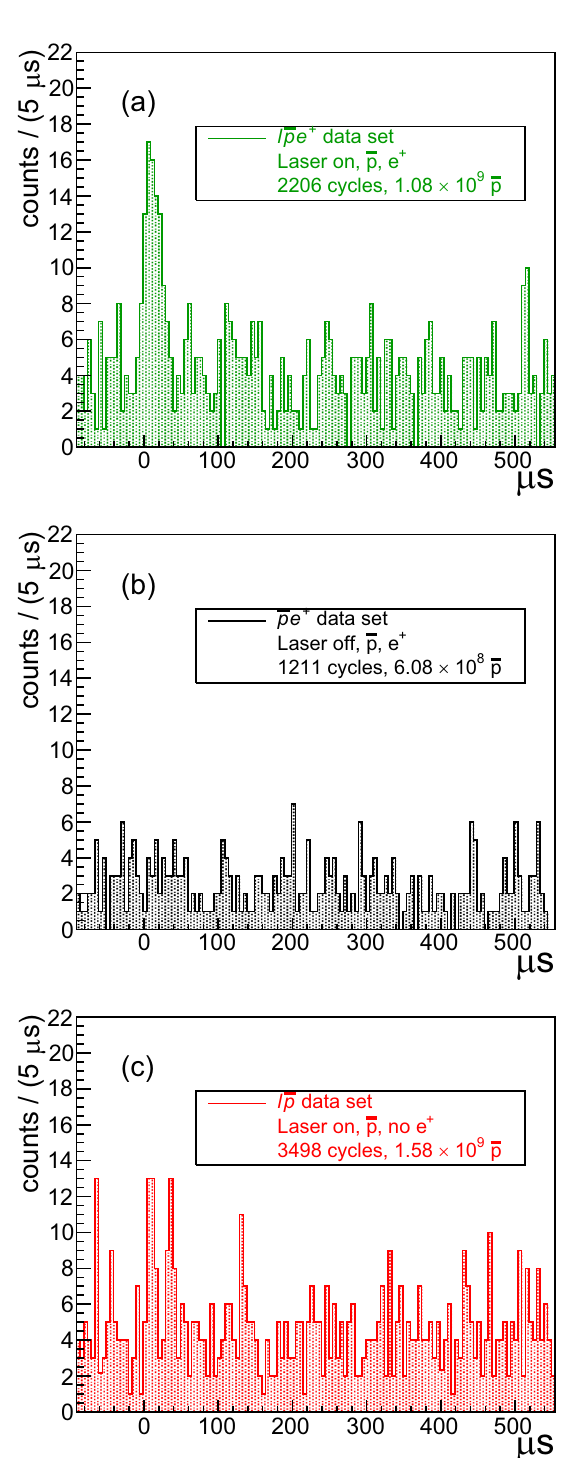
Fig. 3 Time distribution of external detector scintillator array (ESDA) pulses. We show the distributions of the coincident pulses with mean amplitude >250 mV, detected after 1 μ s from the laser fi ring time for the three samples of data: a l (cid:1) pe þ , b (cid:1) pe þ , and c l (cid:1) p. Note that the number of (cid:1) p and (cid:1) H cycle are different in the three samples and that the number of counts due to cosmic rays scales linearly with the number of (cid:1) H cycle , while the counts due to annihilations are proportional to the total (cid:1) p number. The effect of the resulting normalization is mainly to reduce the counts in c relative to those of a by a factor of ~1.5, and to increase the counts in b relative to those of a by a factor of